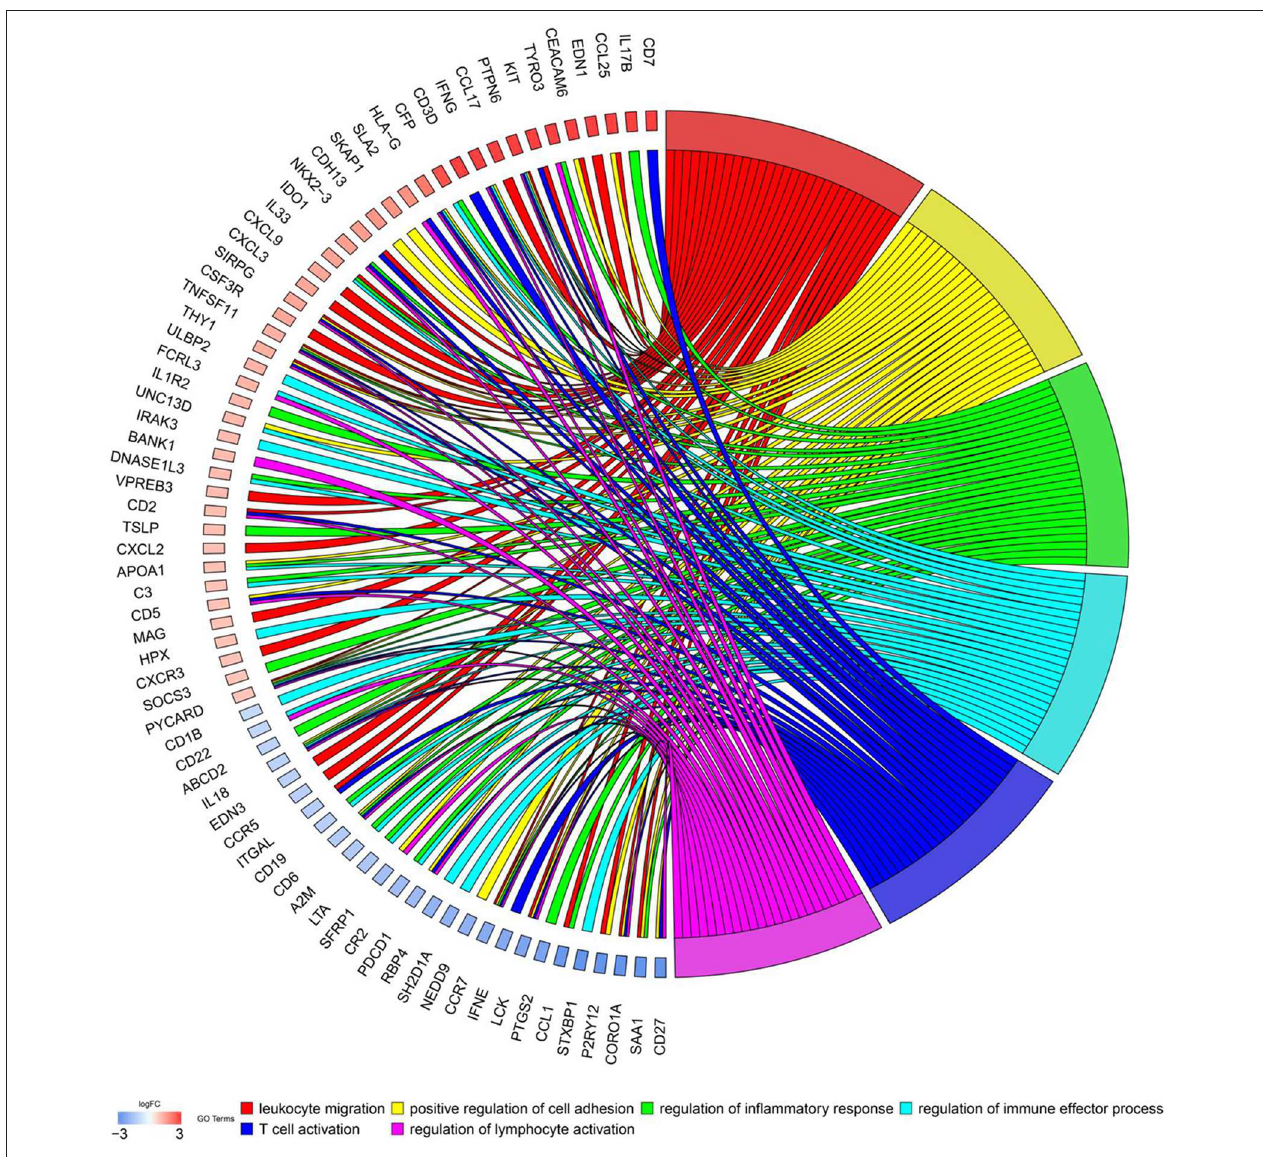
FIGURE 2 | Chord chart of prognostic